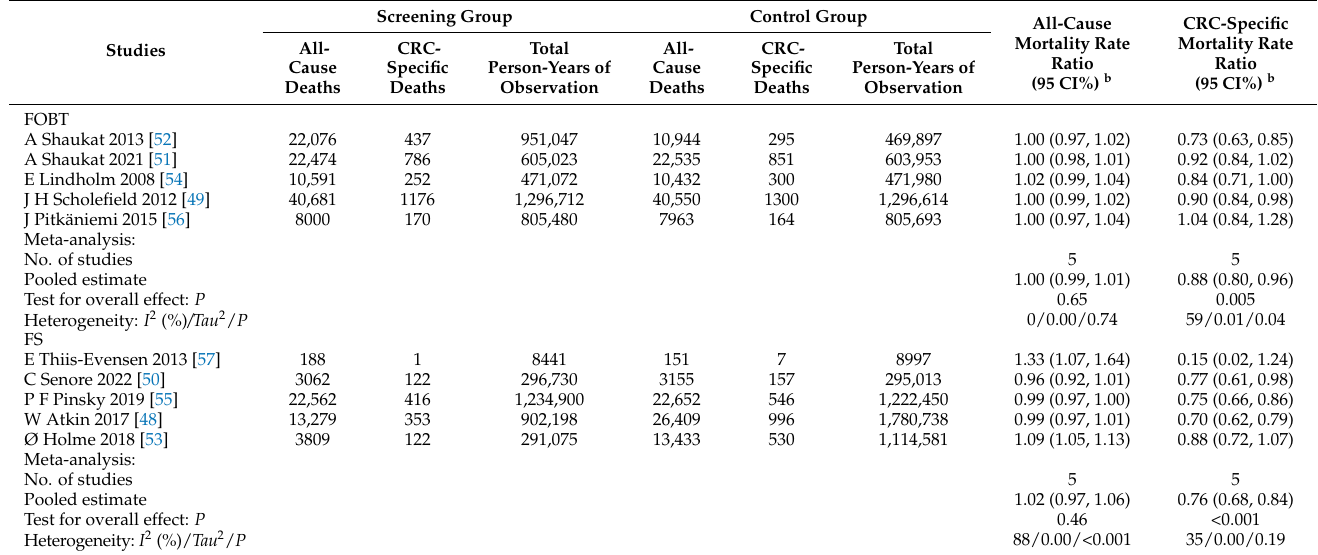
Table 2. Overview of randomized controlled trials on impact of CRC screening: results on all-cause and CRC-specific mortality (Intention-to-screen analyses a